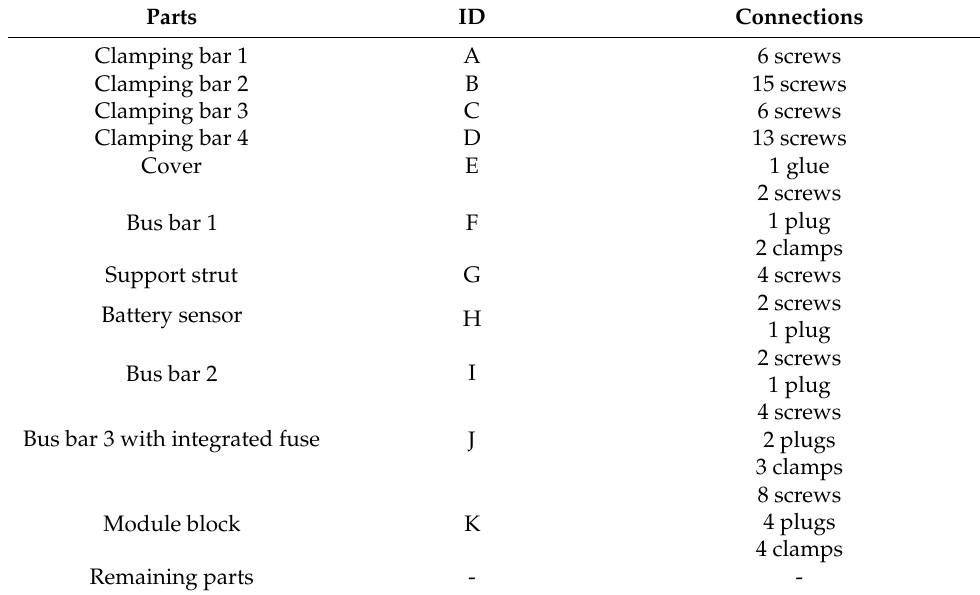
Table 3. Battery parts and connections. The IDs for the different components refer to Figure 4.